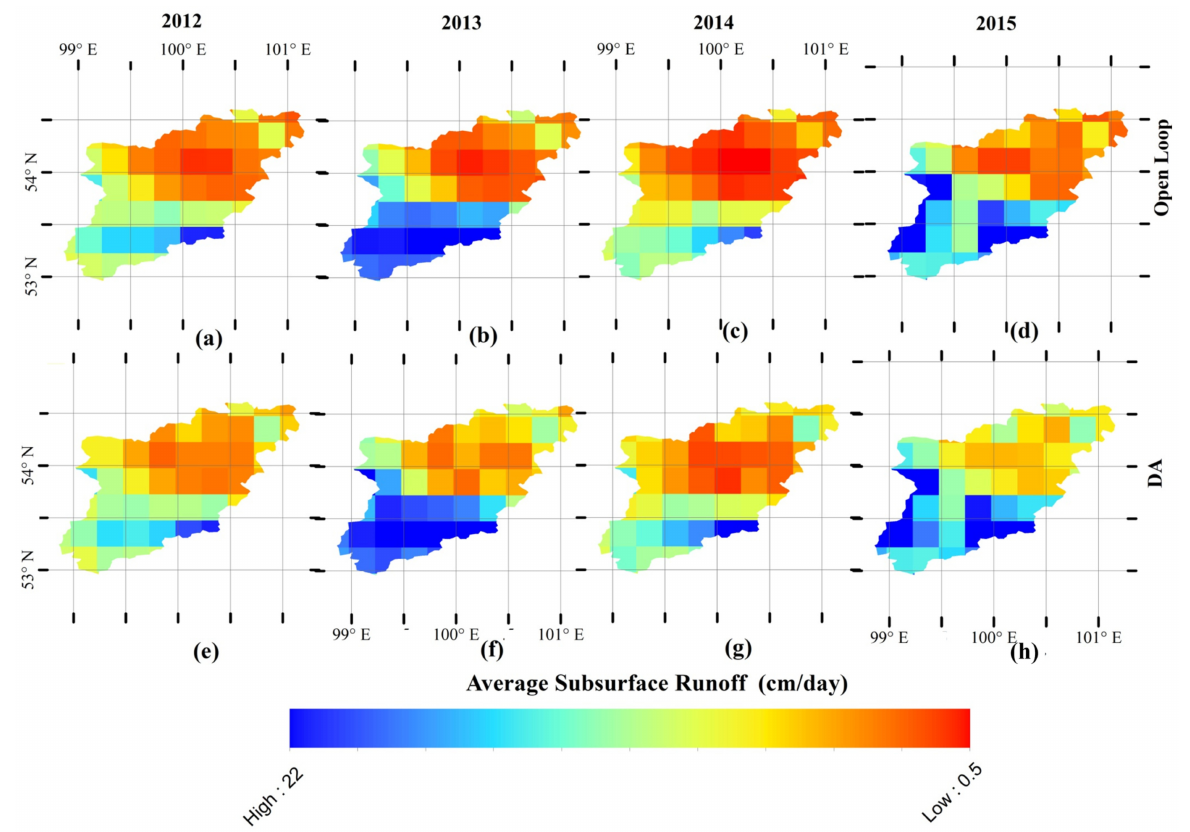
Figure 10. Represents spatial pattern of sub-surface runoff over Iya Basin. Annual mean from open loop are shown in top row ( a – d ), from DA in bottom row ( e – h ). Figure 11 represents the time-series of the streamflow generated from routing the surface and sub-surface runoff with respect to the gauge data over the Tulun gauge station. The gray line represents the in situ gauge streamflow. The streamflow generated from the open loop data is represented in orange color, whereas the streamflow generated from the assimilated soil moisture data is shown in blue color. The time-series represented is from the year 2010 to 2015. From the time-series, it is clearly visible that bias in streamflow is more in the case of open loop compared to the assimilated data. The time-series shows that the streamflow generated from assimilated data is closer to the in situ streamflow rather than the streamflow generated from the open loop data. Thereby, it is clear that the improvement in the soil moisture estimates through data assimilation enhances or improves the streamflow predictions in the permafrost-affected